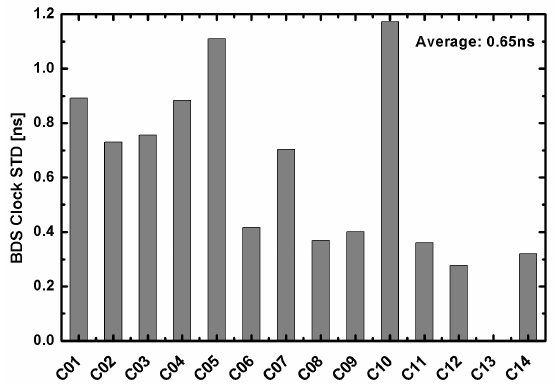
Figure 6. STDs of the real-time BDS clocks compared to the GFZ products.